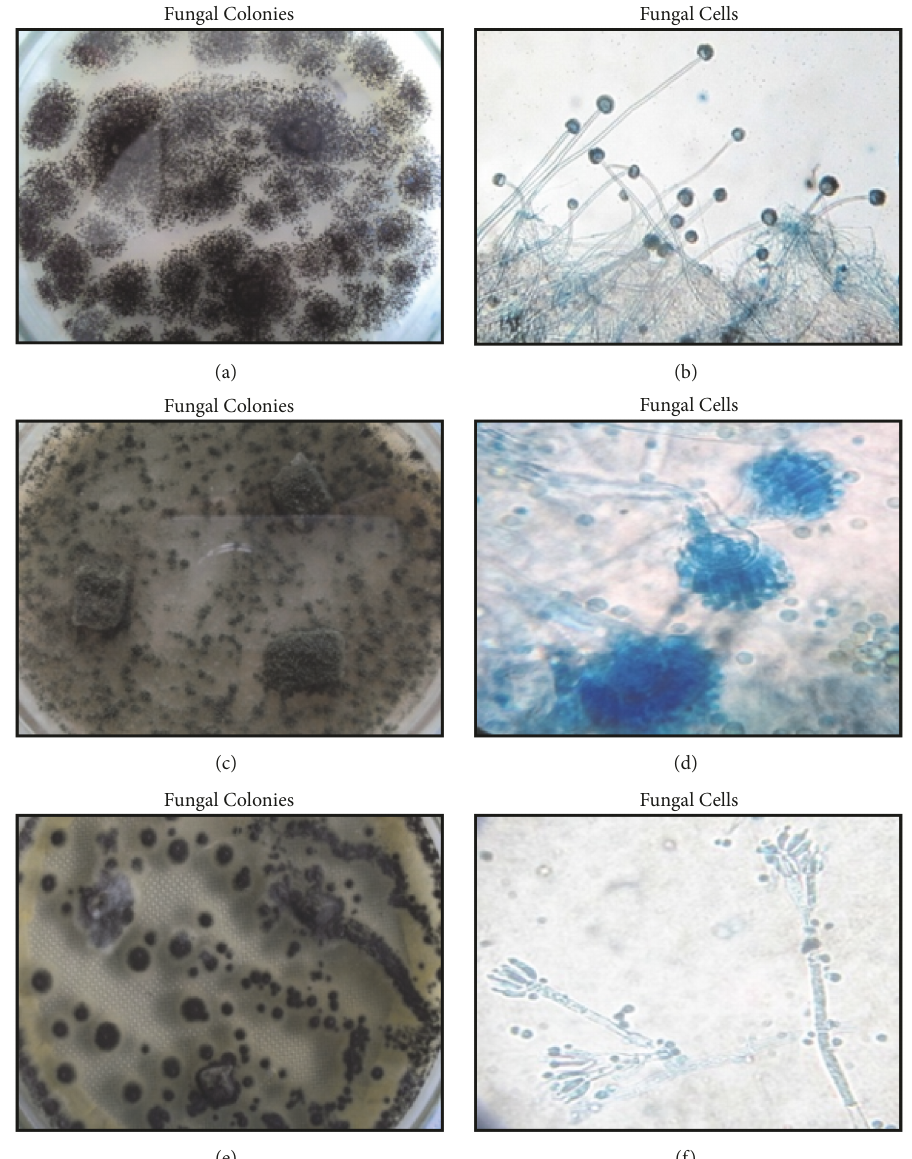
Figure 3: Colonial (left) and microscopic (right) characteristics (400X) of the three Cd tolerant fungal isolates with the highest percentage of Cd biosorption efficiency. Fungal isolates 3 (a and b) and 4 (c and d) were identified as Aspergillus spp. (a-d) while fungal isolate 6 (e and f) was identified as Penicillium